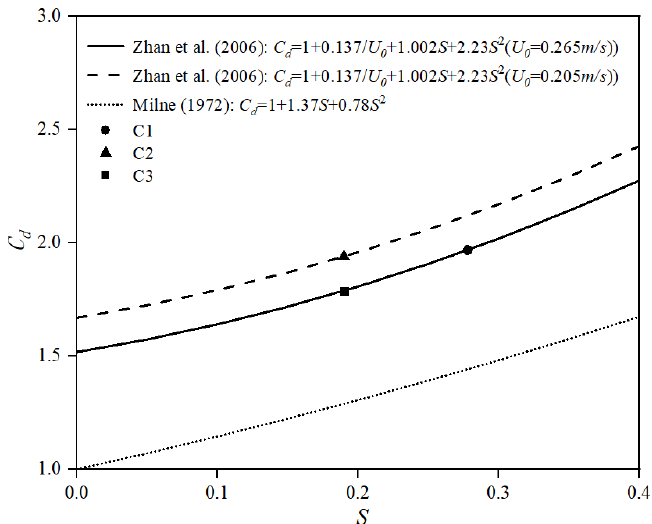
Figure 4. The comparison of calibrated values of the porous media coefficient C n and empirical formula for the drag coefficient C d [40,41]. Note that C n = C d